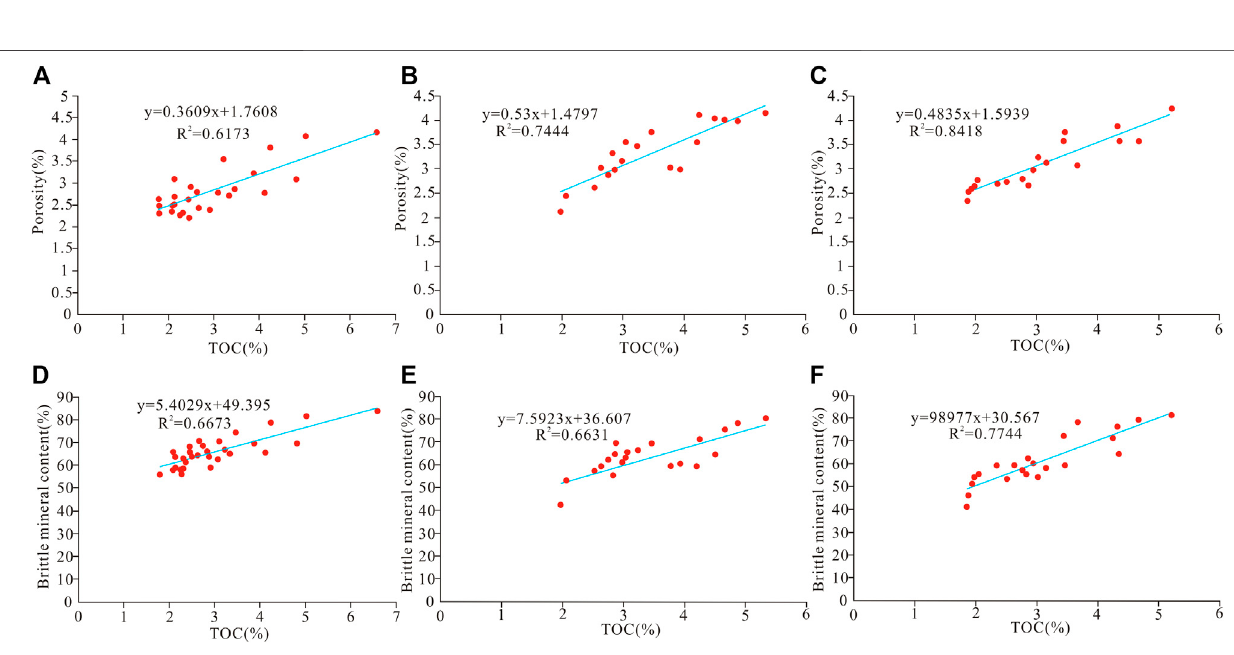
Frontiers in Earth Science |